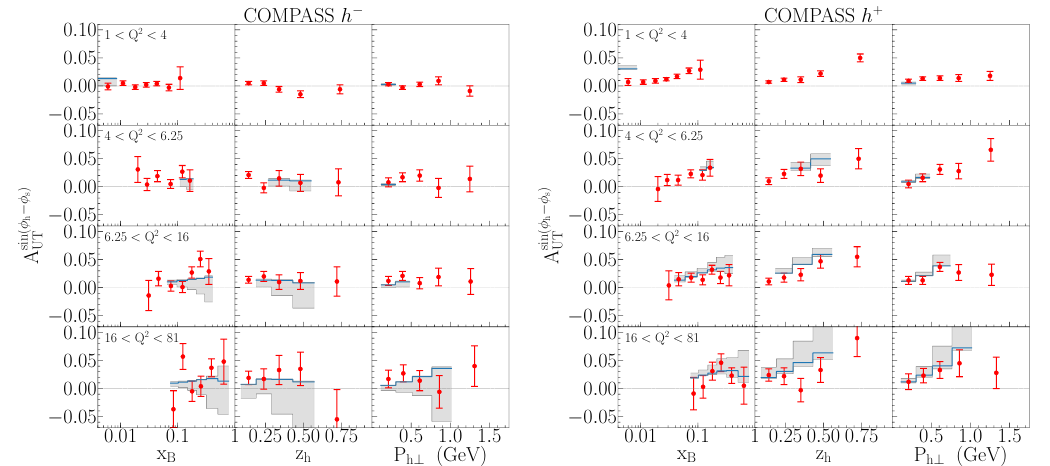
Figure 17 . Left: the COMPASS proton target measurement for h − for 1 GeV 2 < Q 2 < 4 GeV 2 , 4 GeV 2 < Q 2 < 6 . 25 GeV 2 , 6 . 25 GeV 2 < Q 2 < 16 GeV 2 , 16 GeV 2 < Q 2 < 81 GeV 2 from top to bottom [43]. Right: same as the left except for h + production. The central curve and uncertainty band are generated using the result from fit 2b in table 1.